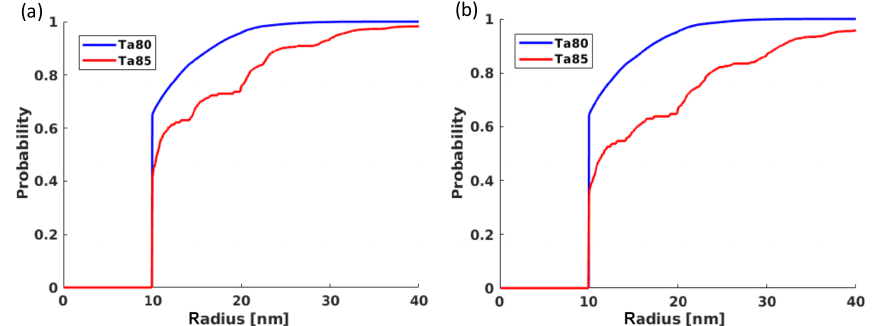
Figure 11. Spherical contact distributions for the pore space in the xz slice at (a) 600nm and (b) 1200nm over the substrate. At these heights, Ta85 is clearly coarser than Ta80. Values less than 1 pixel are not considered – they are not reliable due to the fact that the data sets’ resolution does not allow for structural details as small as pores to be differentiated.